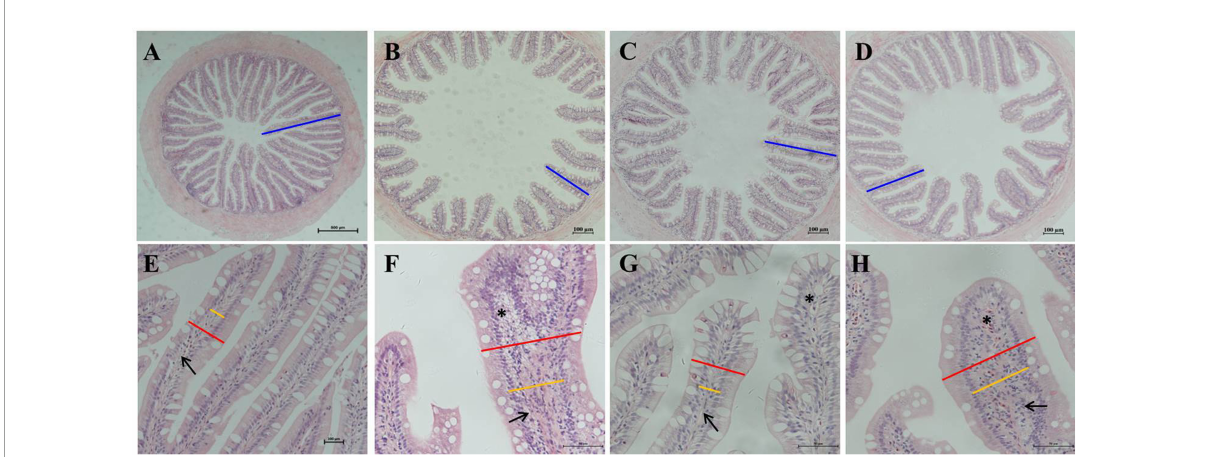
FIGURE1 Hematoxylin-eosin staining in the hindgut of pearl gentian grouper. (A–D) Reduction and fusion of mucosal folds in SBM40, SPC40, and FSBM40 groups. (E–H) Increased width of lamina propria and inflammatory cell infiltration SBM40, SPC40, and FSBM40 groups. (A,E) Fish meal control group; (B,F) 40% SBM substitution for fish meal group; (C,G) 40% SPC substitution for fish meal group; (D,H) 40% FSBM substitution for fish meal group. Blue bar, the height of plica; red bar, the width of plica; yellow bar, the width of lamina propria; arrow, lamina propria; asterisk, inflammatory infiltration.